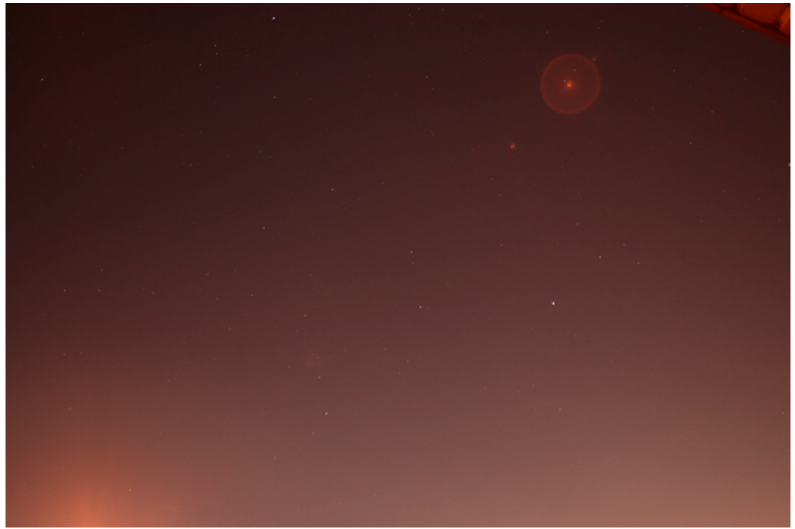
Figure 22. A frame from a sequence captured in Cluj-Napoca, before sunrise, facing East. From this sequence, less than one hour long, the system detected 14 satellites, all recognized based on TLE orbital parameter prediction. The range, from prediction, was between 650 and 1300 km. A selection of recognized satellites, compared with their predicted trajectories, is shown in Figure 23.